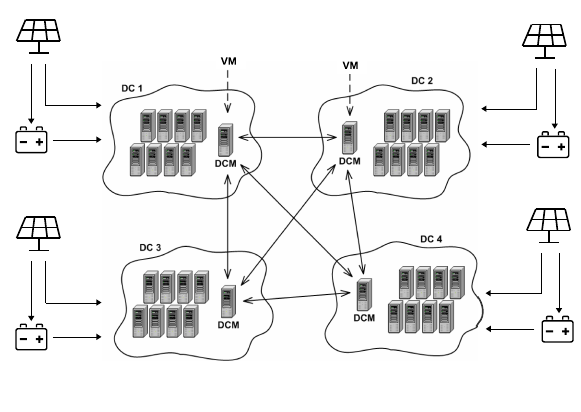
Figure 2. The considered scenario: four DCs equipped with PV panels and energy storage units use EcoMultiCloud for coordinating workload management among the